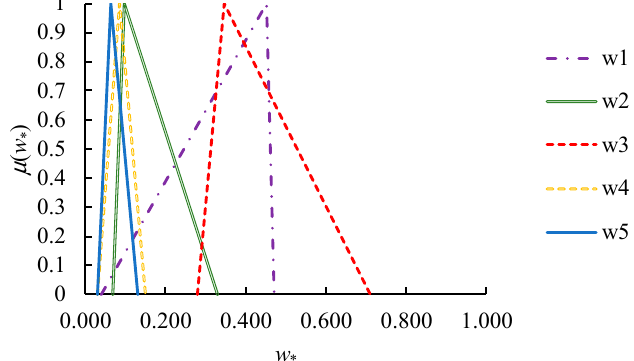
Figure 7. Approximating the FWI results with TFNs.